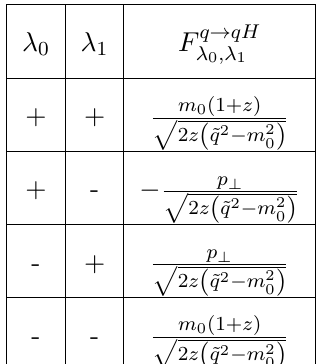
Table 2. Spin-unaveraged splitting functions for q → qH . In addition to the factors given above, each term has a phase e i ( λ 0 − λ 1 ) φ 0 , where λ 0 , 1 = ± 1